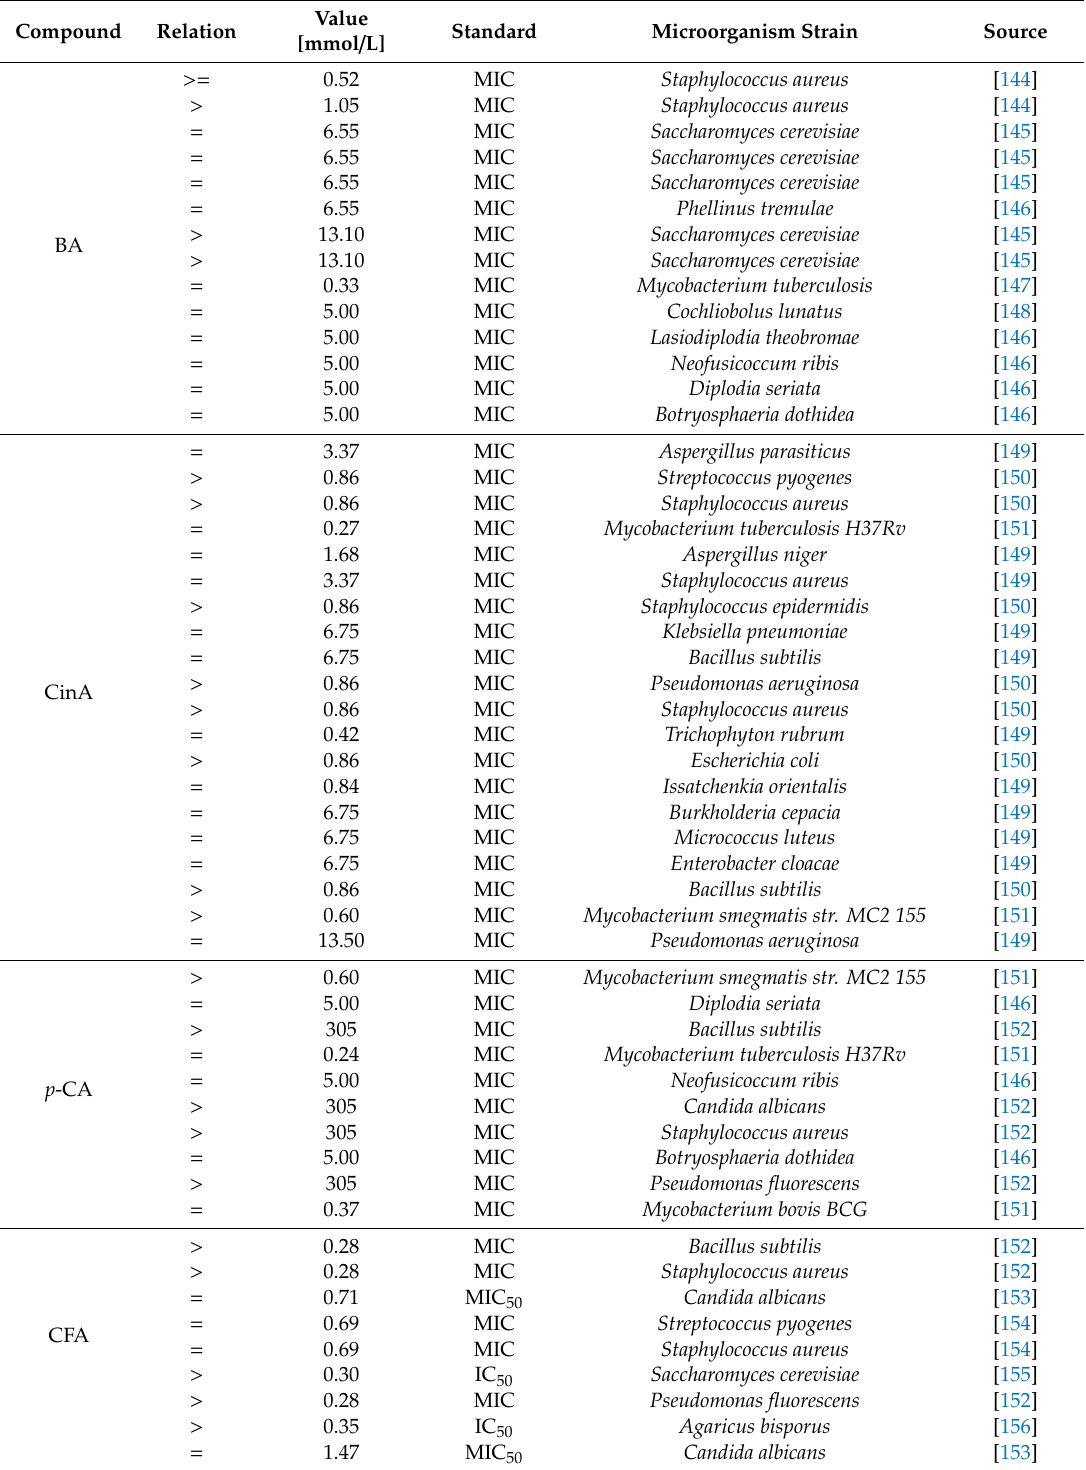
Table 4. Antimicrobial e ff ects of NCA on selected microbial strains.